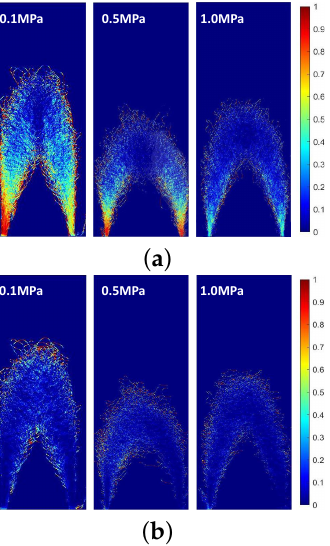
2 D 2 D (cid:105) s . ( a ) (cid:104) n 2 D (cid:105) s ; ( b ) (cid:104) n 2 D (cid:105) s . n 2 D x n x y n y i i (cid:105) m 2 D s under different pressures are shown in Figure 11. i i (cid:105) m 2 D s represents the contribution of the fluc- i i (cid:105) m 2 D s under ordinary pressure at the flame’s tip is x x (cid:105) m 2 D s is predominant nearly within the y y (cid:105) m 2 D s is observed under i i